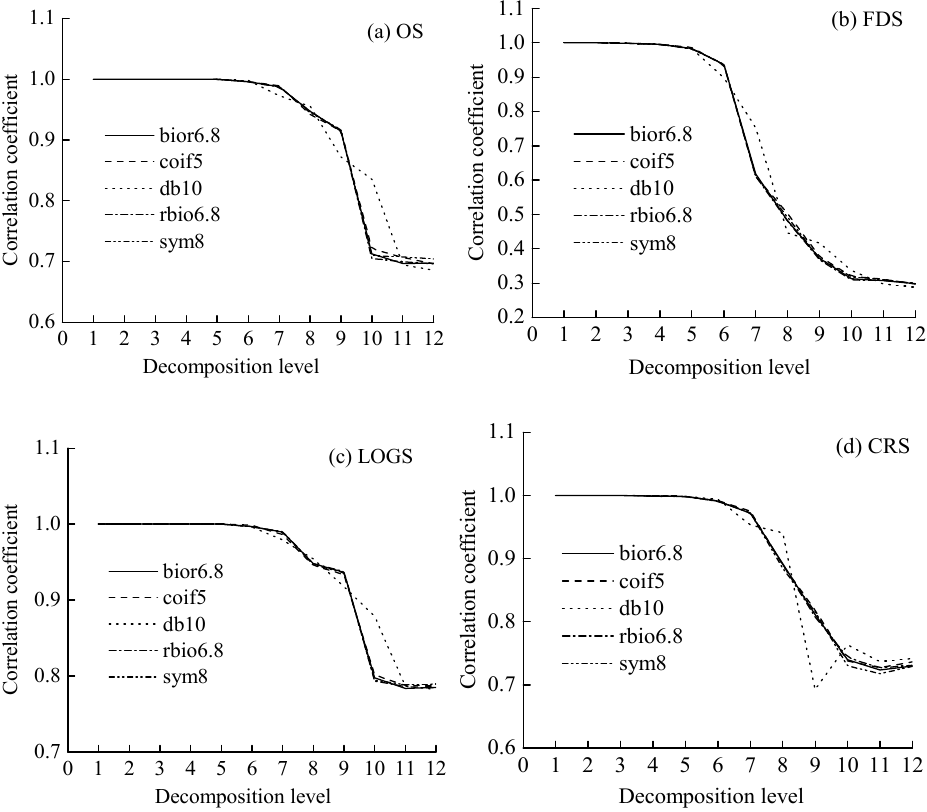
Figure 5. Correlations between reconstructed signals and transformed spectra for different mother wavelets at each decomposition level. ( a ) OS, ( b ) FDS, ( c ) LOGS and ( d ) CRS.